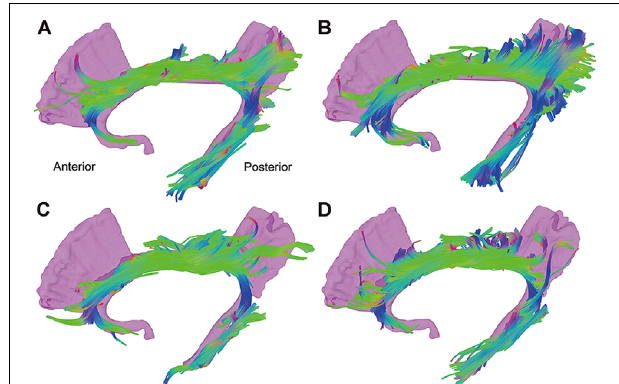
FIGURE 2 | Tractography results of the CB of four representative subjects. The reconstructed CB is a symmetrical sickle-shaped bundle. The fibers in the CB in diabetic representatives (C,D) were slender and more diffusely orientated compared with the healthy controls (A,B) . CB, cingulum bundle; CC, corpus callosum.